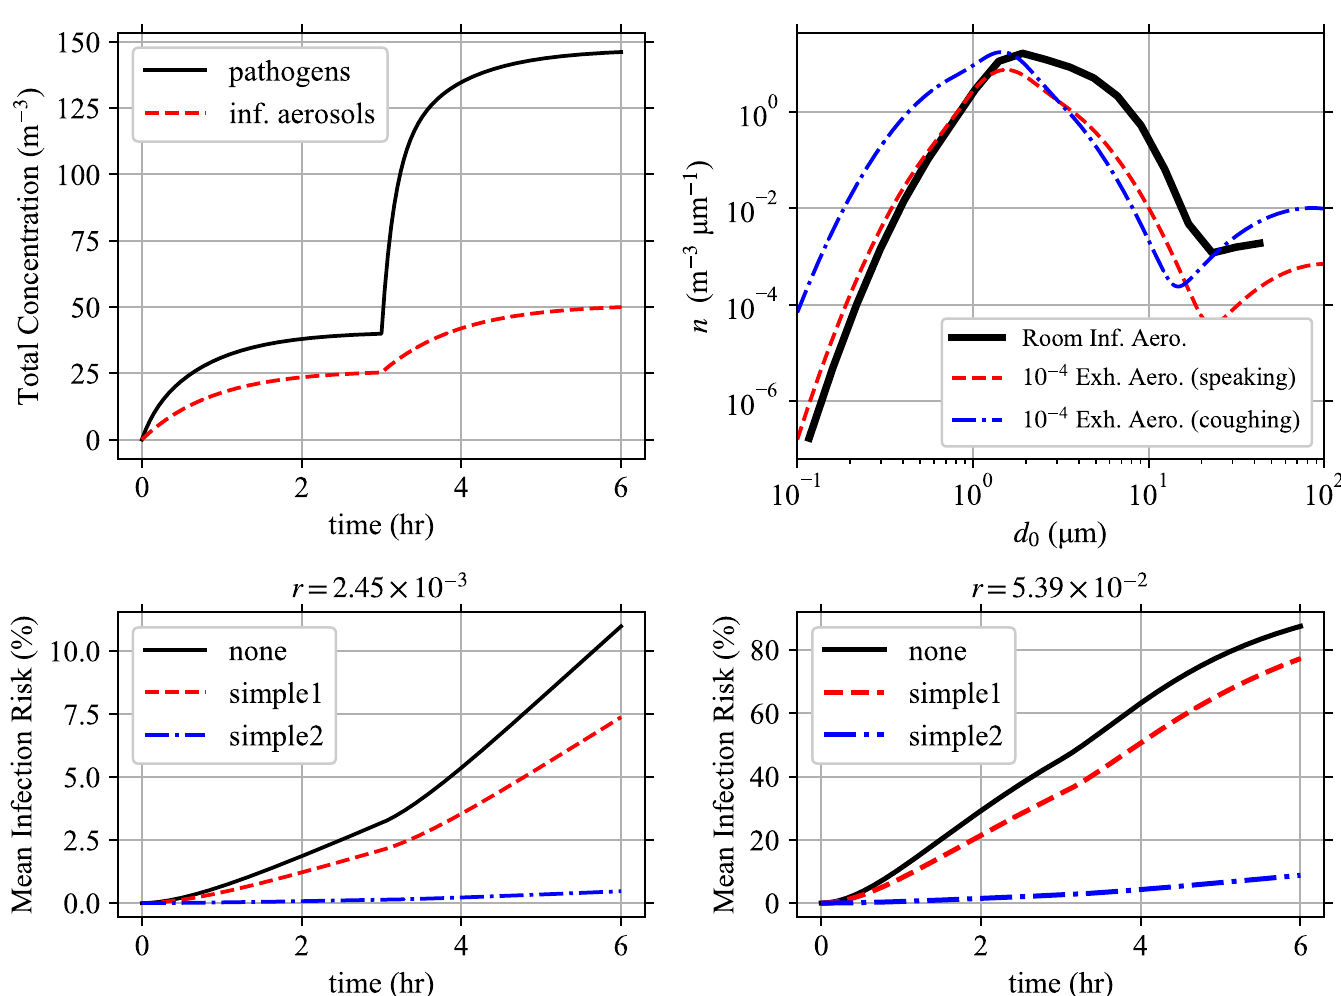
Fig 3. Model solution for example. Solution to the example case. (Top-Left) The total pathogen and infectious aerosol concentrations over time. (Top-Right) The infectious aerosol concentration densities in the room as a function of d 0 at t = 6 hr compared to the aerosol concentration densities being exhaled by speaking and coughing individuals from Johnson et al . [22] scaled by 10 − 4 to make them have comparable magnitudes. (Bottom-Left, Bottom-Right) The mean infection risk R the susceptible individuals based on the mask they are wearing (none, simple1, or simple2) using (Bottom-Left) r = 2.45 × 10 − 3 (Bottom-Right) r = 5.39 × 10 − 2